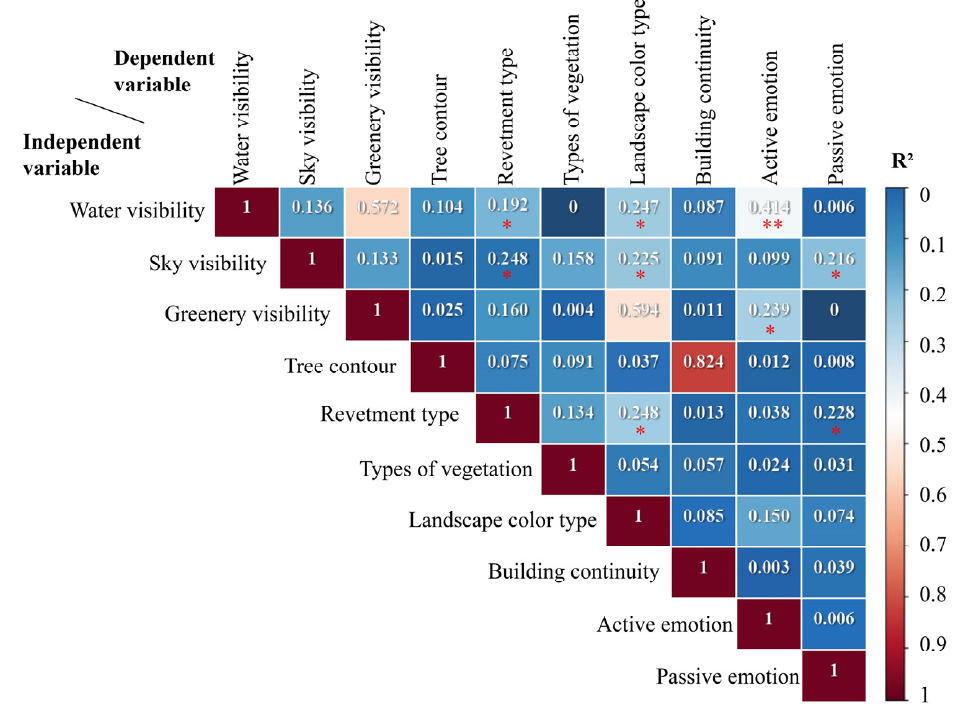
Figure 12. Correlation matrix of the variables. The color indicates the magnitude of the coefficients between the variables (** p < 0.01, * p < 0.05).